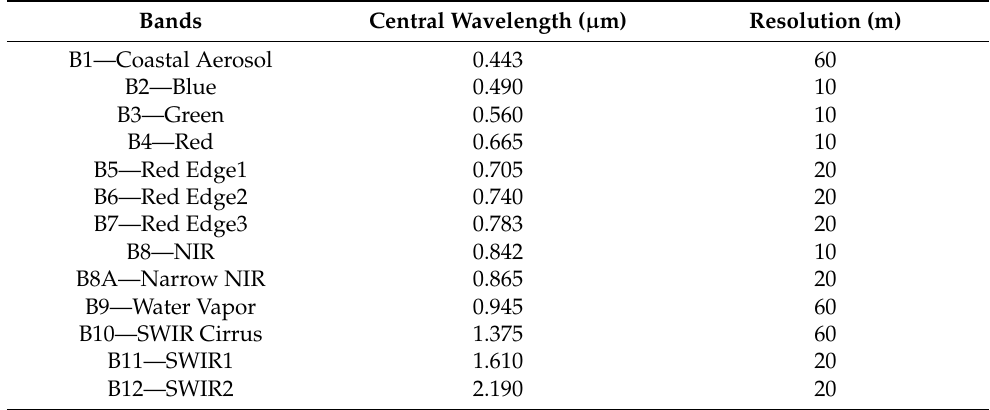
Table 1. Features of Sentinel-2A images.